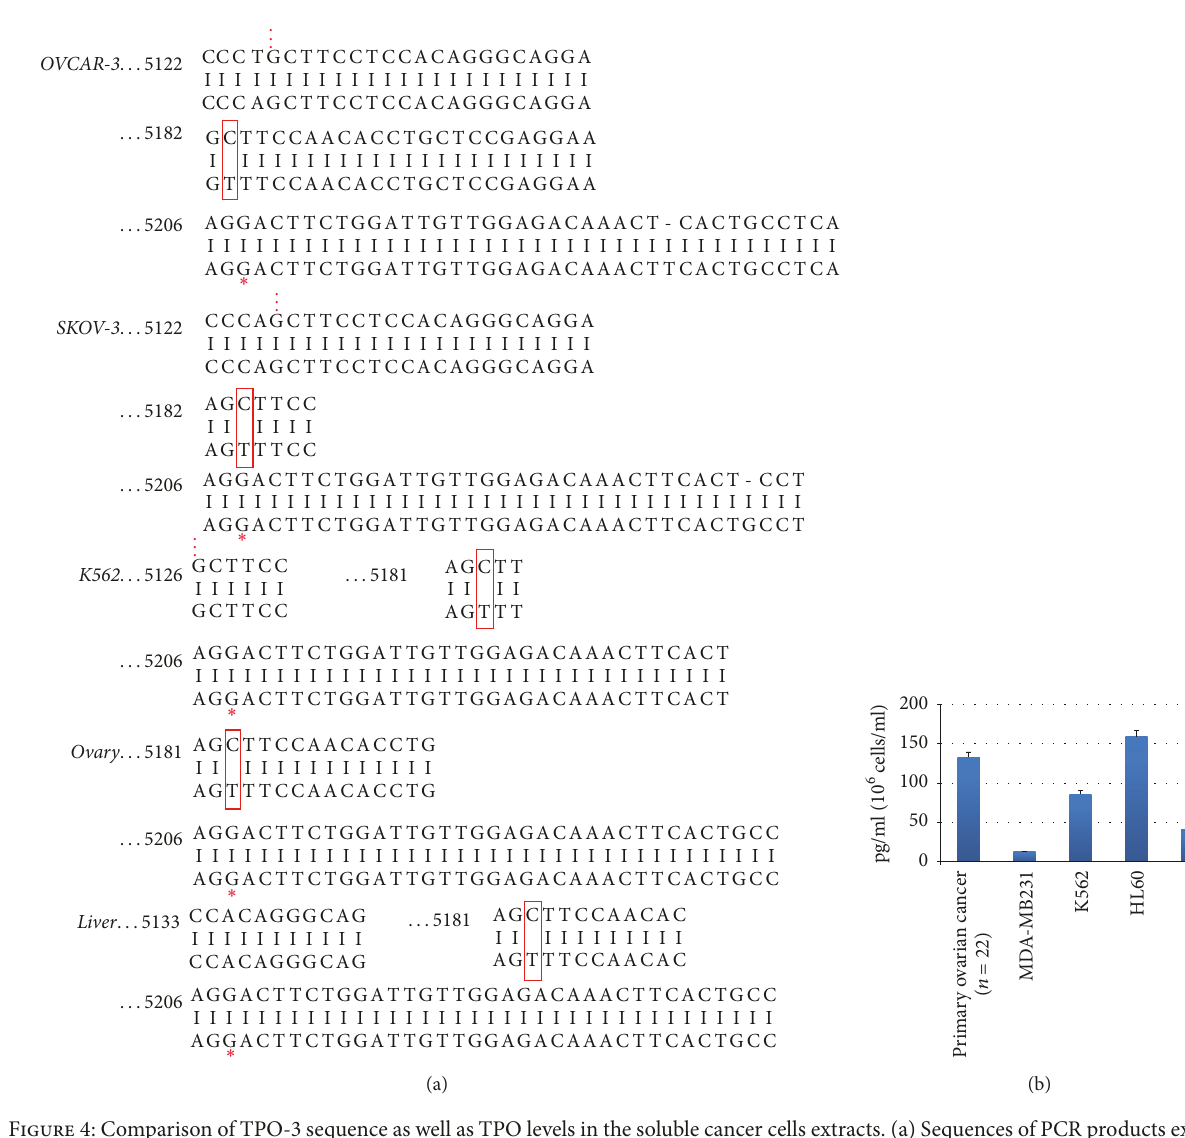
Figure 4: Comparison of TPO-3 sequence as well as TPO levels in the soluble cancer cells extracts. (a) Sequences of PCR products extracted from agarose gel bands are shown in the upper line. R2 primer was used for sequencing. Boxes show a C/T 5183 SNP. “ ... ” and “ ∗ ” symbols refer to two different alternative splicing sites (12bp and 116bp deletions, resp.). A 116bp deletion characterizing TPO-3 is detected. BLAST reveals no significant mutation. (b) TPO levels in the soluble cancer cells extracts evaluated by enzyme-linked immunosorbent assay (ELISA) for 10 6 cell/ml (the mean of three experiments) from OVCAR-3 NIH cell line, breast cancer MDA-MB231 cell line (as control),